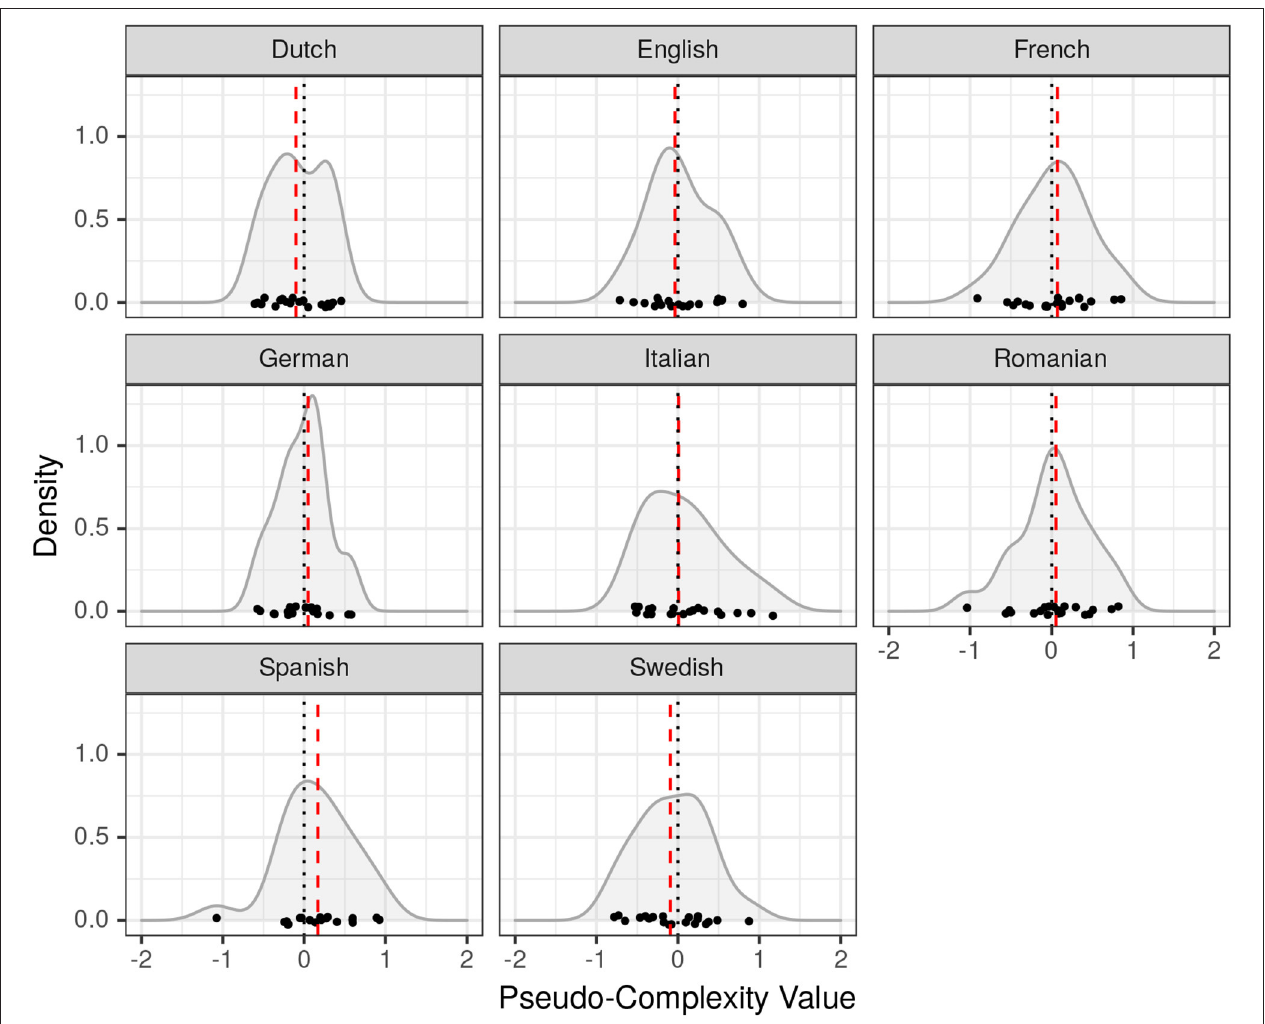
FIGURE 2 | Densities of pseudo-complexity values generated by Brownian motion along the Indo-European phylogeny in Figure 1 . Red dashed lines indicate median values.